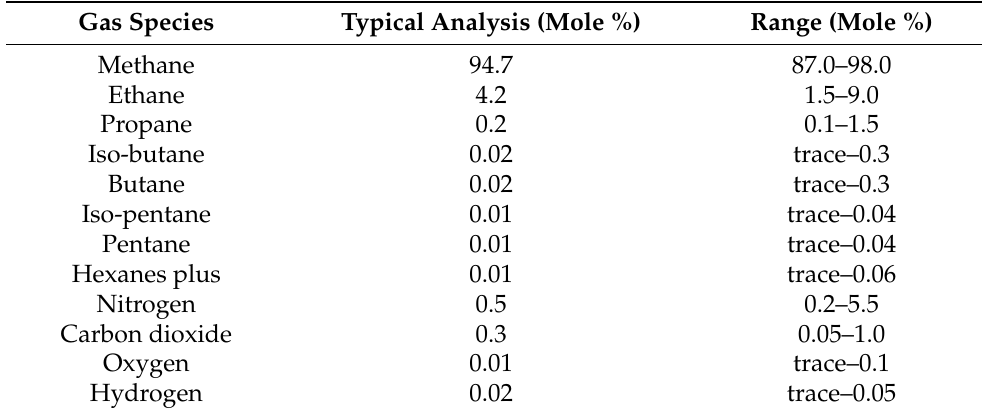
Table A1. Typical natural gas composition